Question: Compose a caption that would accompany this figure in a paper.
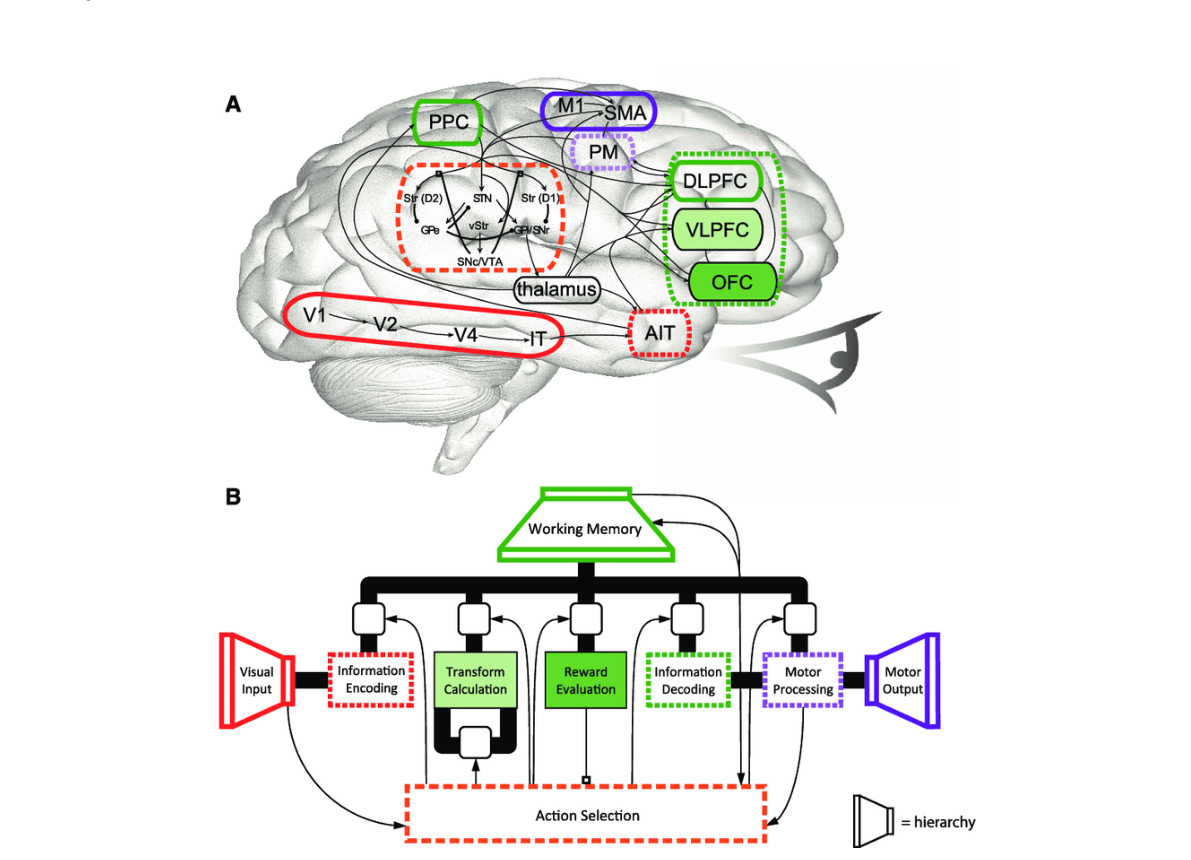
Answer: This illustration represents a large-scale 3D brain model, inspired by Spaun.(a) It highlights the main brain structures of Spaun and their connections. (b) It depicts communication pathways within Spaun’s brain: thick black lines represent connections within the cortex, while thin lines show connections between the Basal Ganglia and the cortex. Image source: [24]